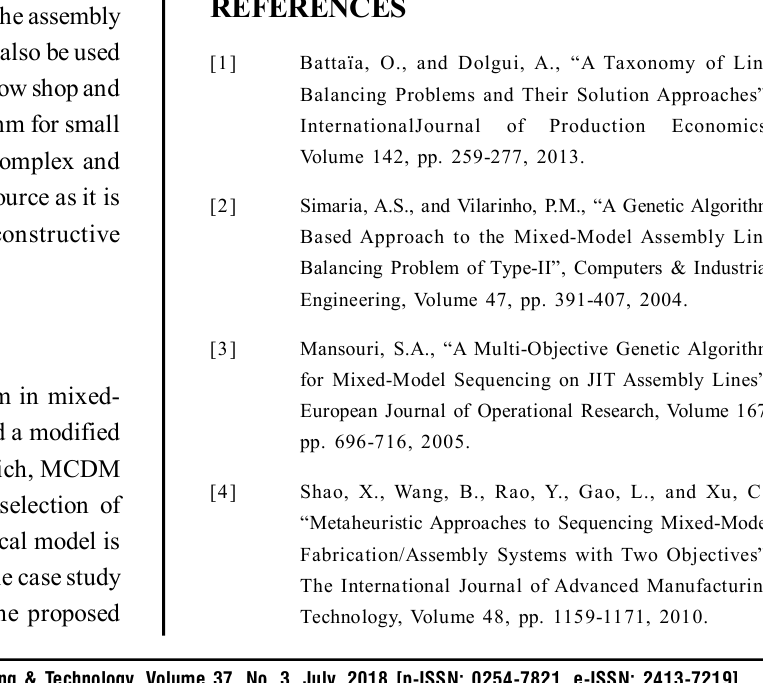
TABLE 8. POSITIVE SEPARATION, NEGATIVE SEPARATION AND RELATIVE CLOSENESS OF ALGORITHMS Model Sequences/Criteria INEH SISa+